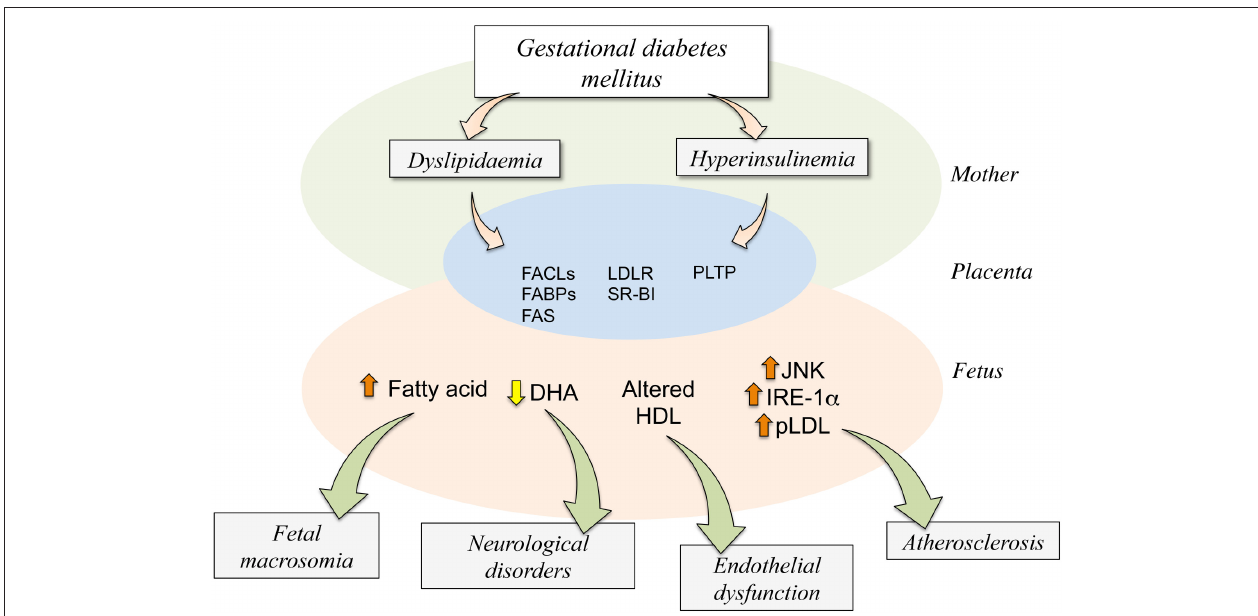
FIGURE 3 | Potential consequences of dyslipidaemia and hyperinsulinemia on the human fetoplacental unit from gestational diabetes mellitus. Gestational diabetes mellitus (GDM) results in maternal ( Mother ) metabolic alterations leading to dyslipidaemia and hyperinsulinemia. These two abnormal metabolic conditions are associated with higher expression and activity of several molecules involved in the placental transport (FABPs,) and metabolism (FACLs, FAS, PLTP) of lipids or its receptors (LDLR, SR-BI) in the human trophoblast ( Placenta ). These changes result in altered transplacental transport of several signaling molecules via the trophoblast barrier, ending in increased ( ) fatty acid, reduced ( ) docosahexaenoic acid (DHA), or altered composition or function of high-density lipoprotein (HDL) in the fetoplacental circulation ( Fetus ). Since these changes in the capacity of transport by the placenta increased levels of endoplasmic reticulum stress (JNK, IRE-1 α ) and atherosclerotic [phospholipolyzed LDL (pLDL)] markers are detected in the fetal endothelium. Adverse fetal outcome results from alterations in the fetal circulating or tissue levels of these molecules in GDM compared with normal pregnancies. Increased level of fatty acids regards with a higher incidence of fetal macrosomia while a decrease in the fetal plasma level of DHA associates with increased number of neurological disorders. Additionally, less functional HDL could potentially result in endothelial dysfunction in the newborn, and atherosclerosis could result from increased ERS markers. Composed of information reported by Ethier-Chiasson et al. (2007) , Marseille-Tremblay et al. (2008), Herrera and Ortega-Senovilla (2010), Scifres et al. (2011), Olmos et al. (2012), Pagán et al. (2013), Araújo et al. (2013), Sreckovic et al. (2013), Herrera and Desoye